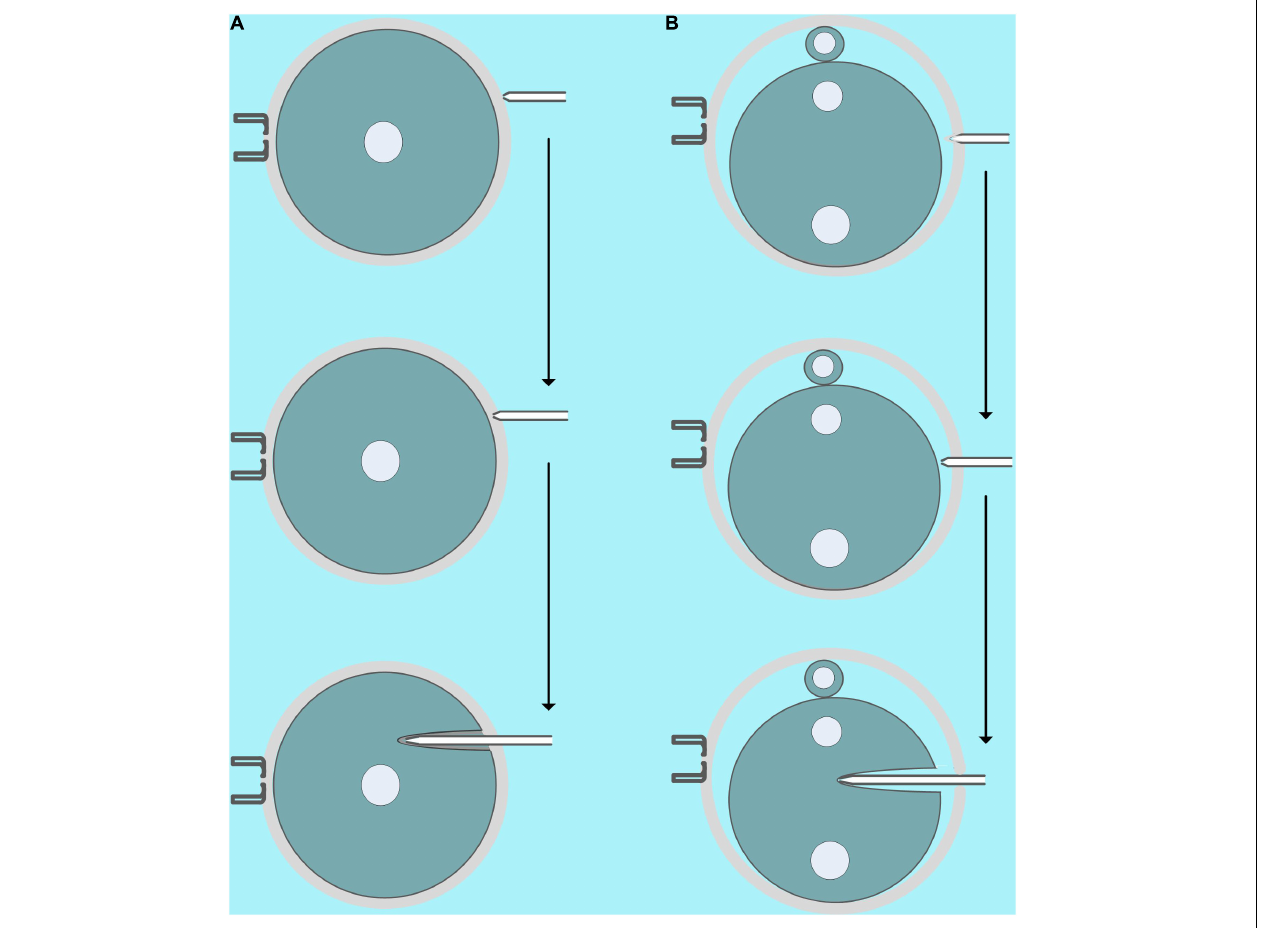
FIGURE 4 | Schematic diagram of microinjection. (A) Microinjection diagram of GV oocytes [microinjection of cumulus–oocyte complex (COC) is similar]. First, the microinjection pipette should be close to, instead of pressing, the zona pellucida, and then a small piezoelectric pulse was used to incompletely penetrate the zona pellucida. Finally, the microinjection needle with the incomplete zona pellucida and the cell membrane is inserted into 1/3 to 2/3 of the oocyte, and then the oil pressure microinjector is turned into a vomiting state, and a minimum amount of piezoelectric pulse is given at the same time. (B) Microinjection diagram of fertilized eggs (microinjection of MII oocytes, two- and four-cell stage embryos are similar). First, the microinjection pipette presses the zona pellucida, and then an intermediate piezoelectric pulse is used to completely penetrate the zona pellucida. Finally, the microinjection needle is inserted into 1/3 to 2/3 of the cell, and then the oil pressure microinjector enters the vomiting state, and the smallest amount of piezoelectric pulse is given at the same